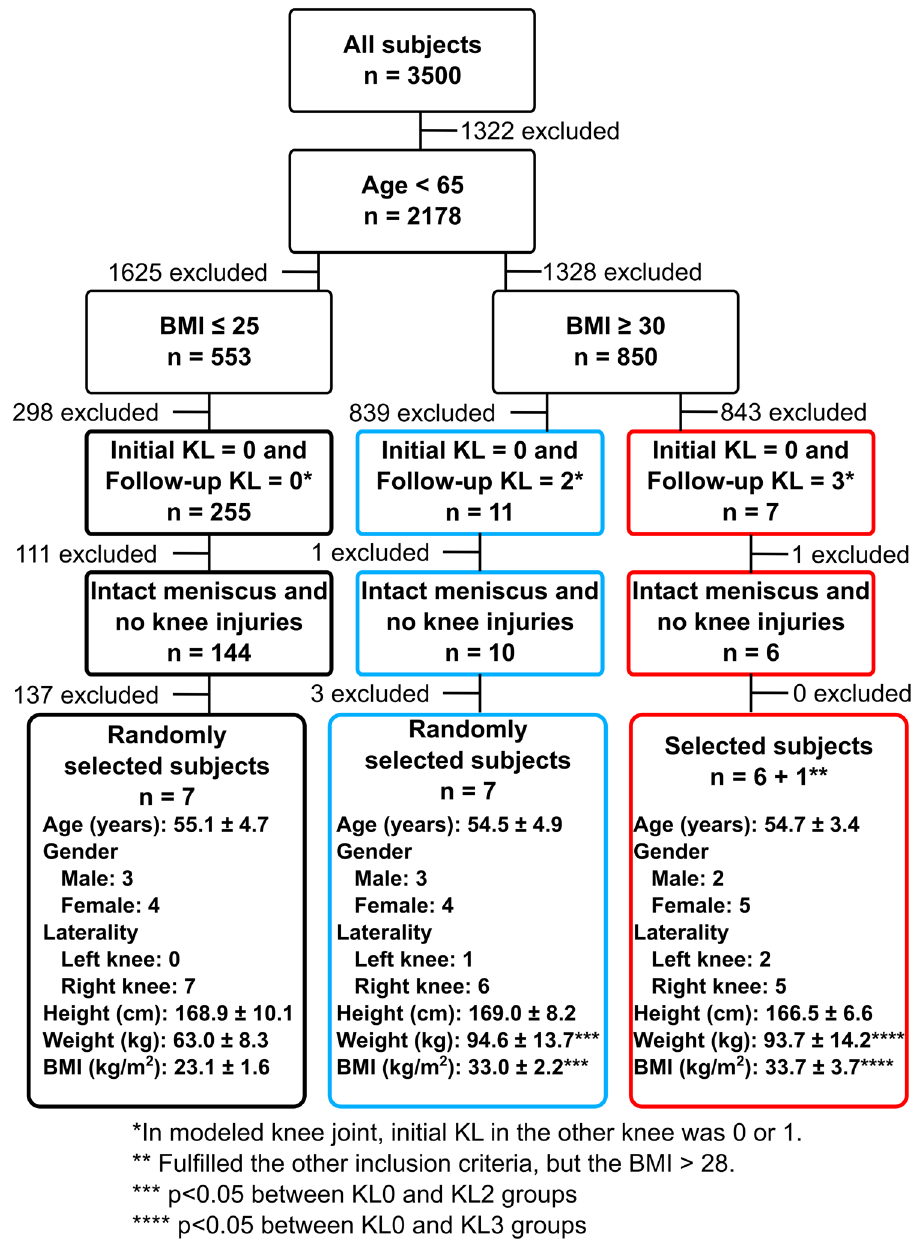
Figure 1. Subject characteristics (mean ± sd) and i nclusion criteria for selecting subjects from OAI database to three different KL groups. In KL0 group subjects’ BMI were less than 25 and in KL2 and KL3 groups more than 30. Except BMI of one KL3 subject was more than 28 since there were only 6 subjects whose BMI was more than 30 and who fulfilled all other inclusion criteria. Inclusion criteria are for knee joints used in FE modelling (3 left and 18 right), but in addition initial KL for non-modelled knee joint had to be 0 or